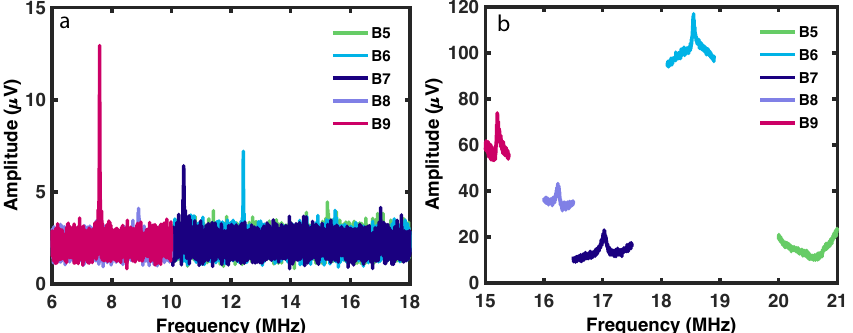
Figure 8. Resonance peaks of the B-series devices in vacuum conditions at room temperature. ( a ) Flexural mode of the devices; ( b ) torsional mode of the